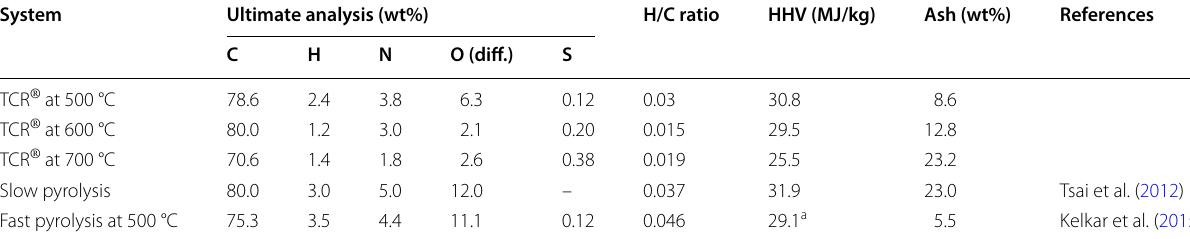
Table 6 Ultimate analysis and physical properties of the char from SCG through TCR ® and other technologies